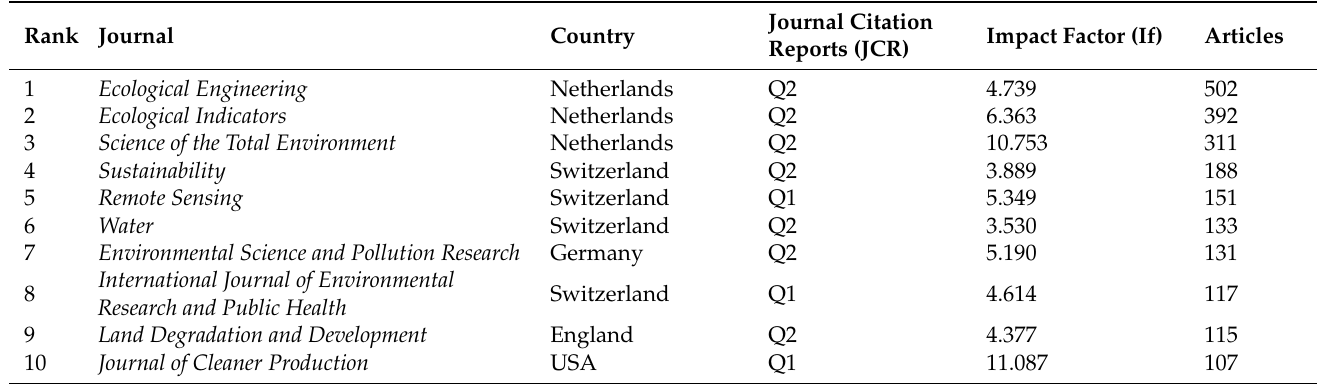
Table 4. Top 10 journals in terms of literature volume in the field of ecological restoration from 1990 to